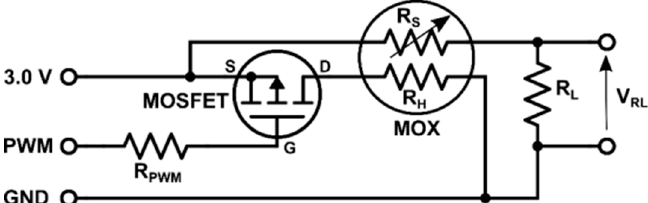
Figure 4. Schematic of the conditioning electronic circuit for each MOX sensor in the MOX deck, using PWM for powering and a voltage divider for read-out.